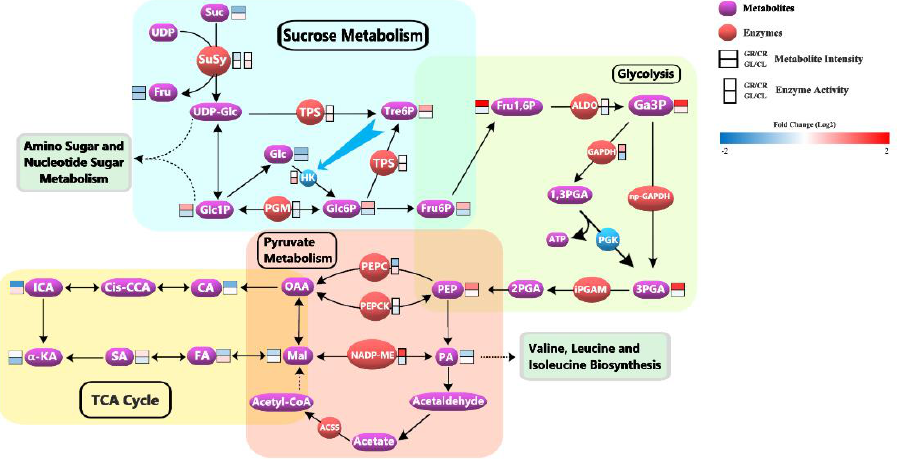
Figure 2. Different phosphoproteins and metabolites are involved in the metabolism of tea plants. Suc: